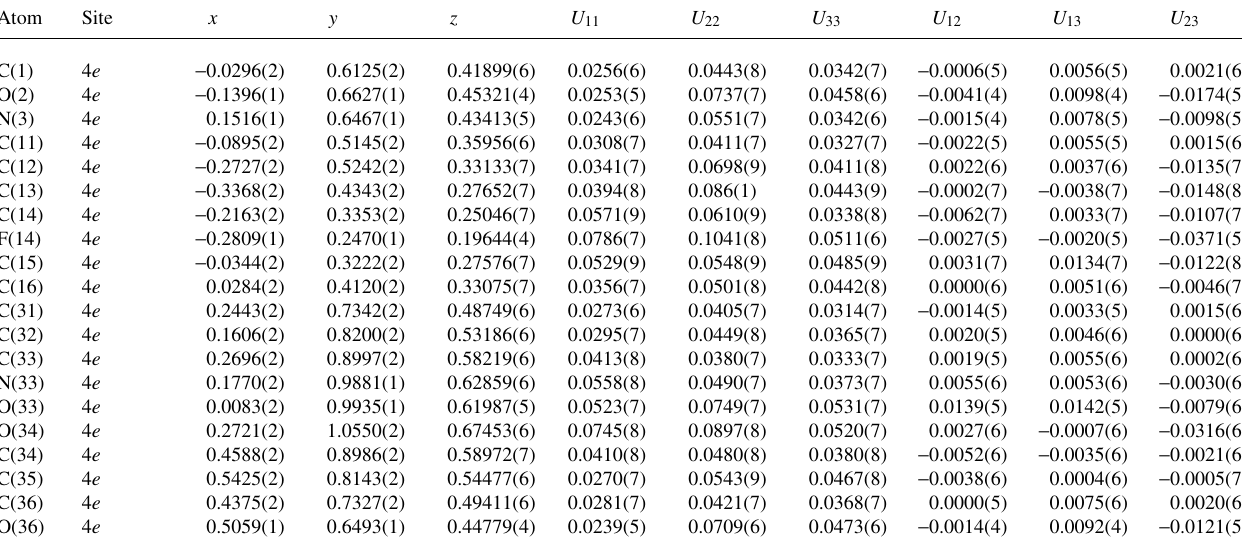
Table 3. Atomic coordinates and displacement parameters (in Å 2 )